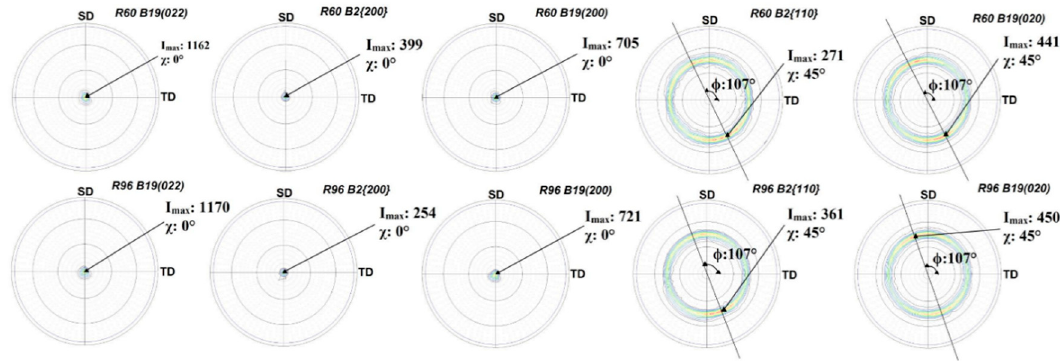
Figure 5. Air-side pole figures for R60 and R96 ribbons with spinning (SD) and transverse directions (TD) as reference.